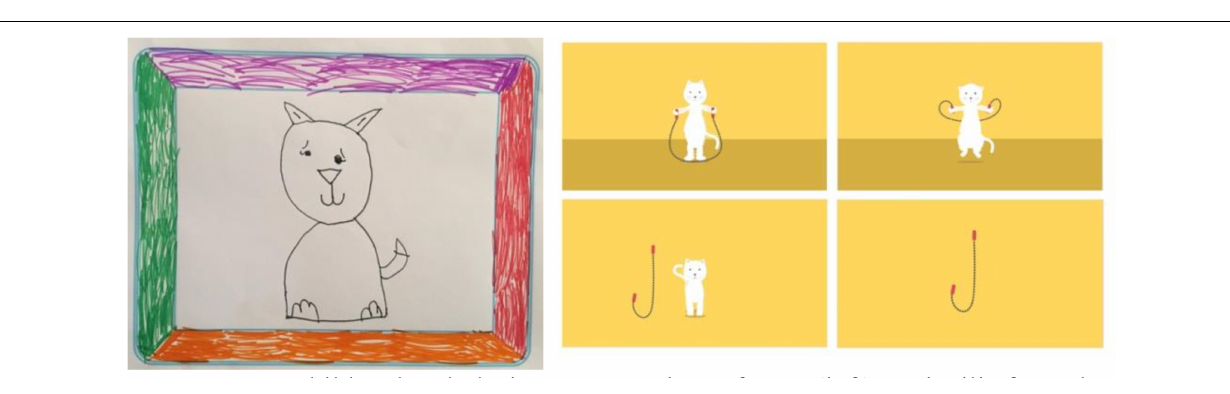
When they complete a letter, they are rewarded with a video.